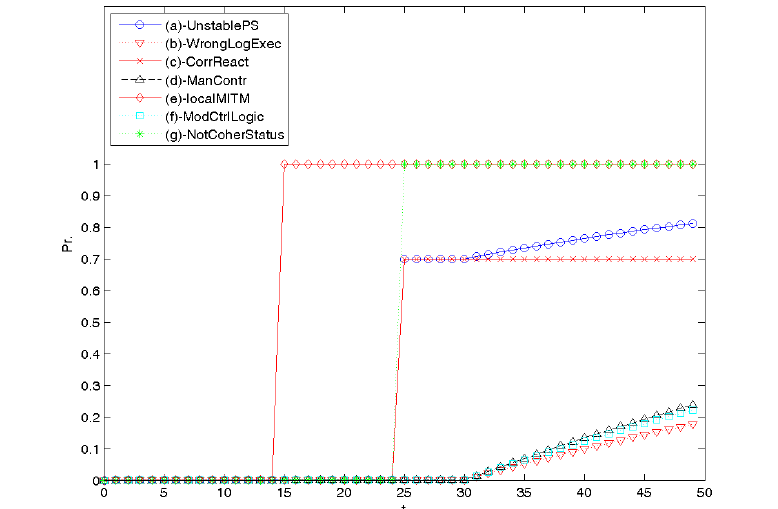
Figure 13. Task: prediction. At time t = 30 on the basis of the observations up to time t , predictions for all subsequent times are